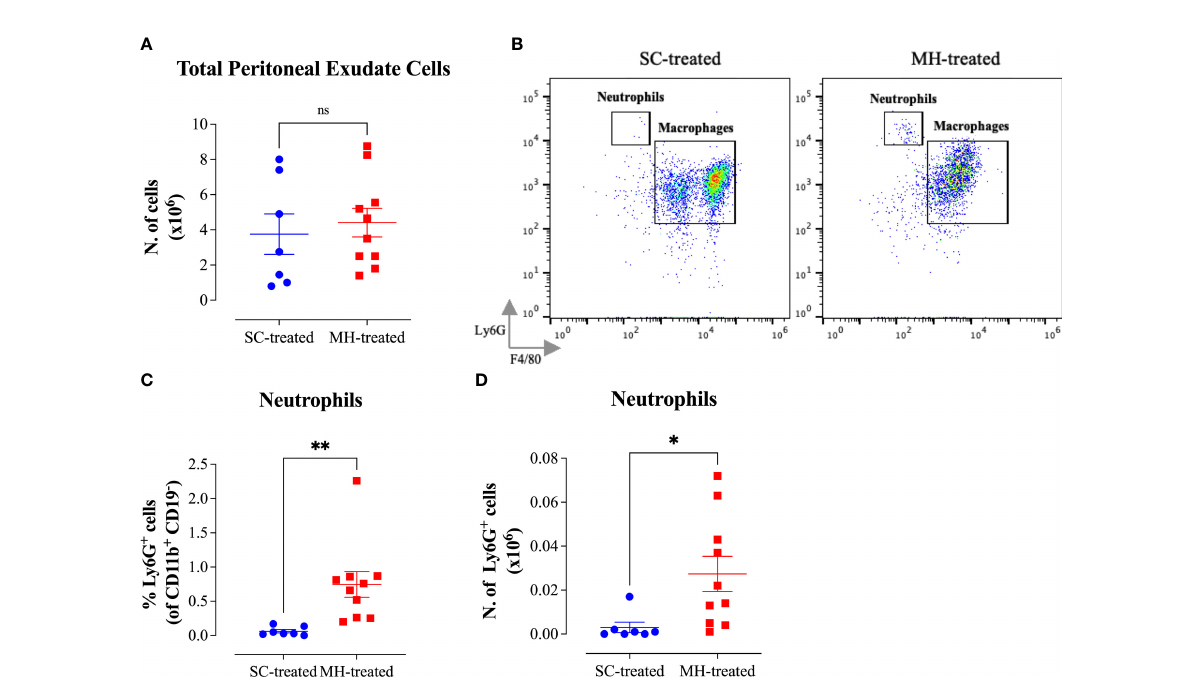
FIGURE 8 Impairment in the peritoneal response following MH administration in MyD88 -/- mice. (A) Total number of PECs following treatment with SC or MH. (B) Representative dot plots showing Ly6G + neutrophils and F4/80 + macrophages within the PECs (gated on CD11b + CD19 - CD11c - cells). (C, D) Quanti fi cation of the percentage (C) and absolute number (D) of neutrophils (Ly6G + cells) in the peritoneal cavity of MyD88 -/- mice following treatment with SC or MH. Asterisks denote statistically signi fi cant differences between the MH-treated and SC-treated groups. The values for individual mice (mean ± SEM) are shown (SC-treated: n=7; MH-treated: n=10), pooled from 2 independent experiments. p values were calculated using the unpaired Student ’ s t-test (ns; p >0.05, *p ≤ 0.05, **p ≤